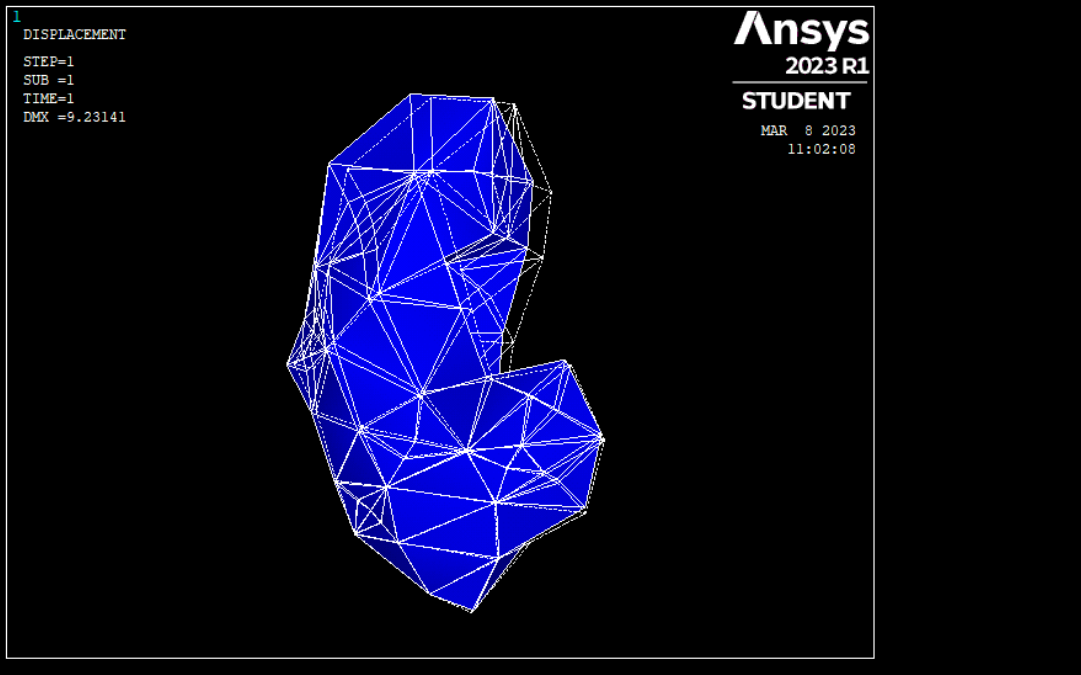
Figure 8. Undeformed and Deformed Geometry for Problem 3 (Nonlinear